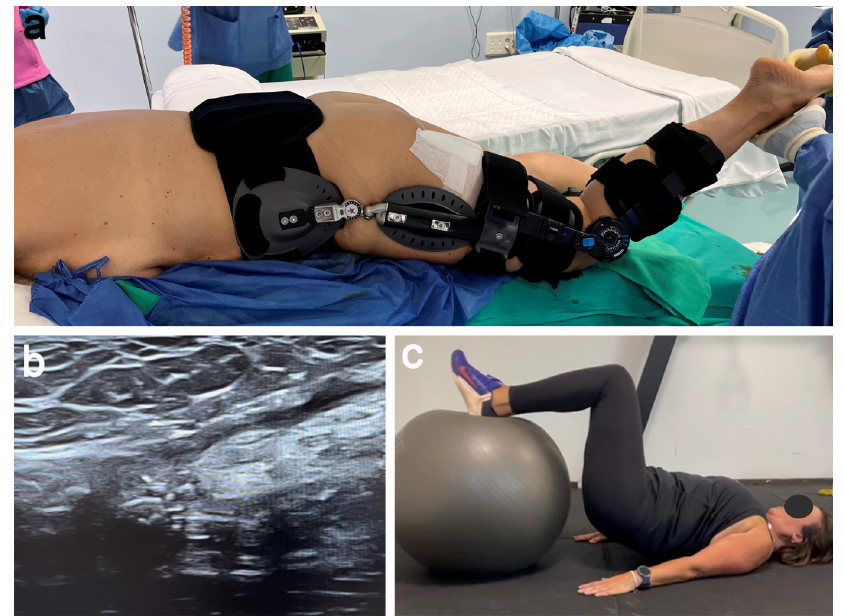
Figure 7. Postoperative rehabilitation. ( a ) Immobilizing splints keeping the knee and hip flexed. ( b ) US (week 12 postoperatively) showed images compatible with the integration of the allograft. ( c ) Rehabilitation process starting at 12 weeks.